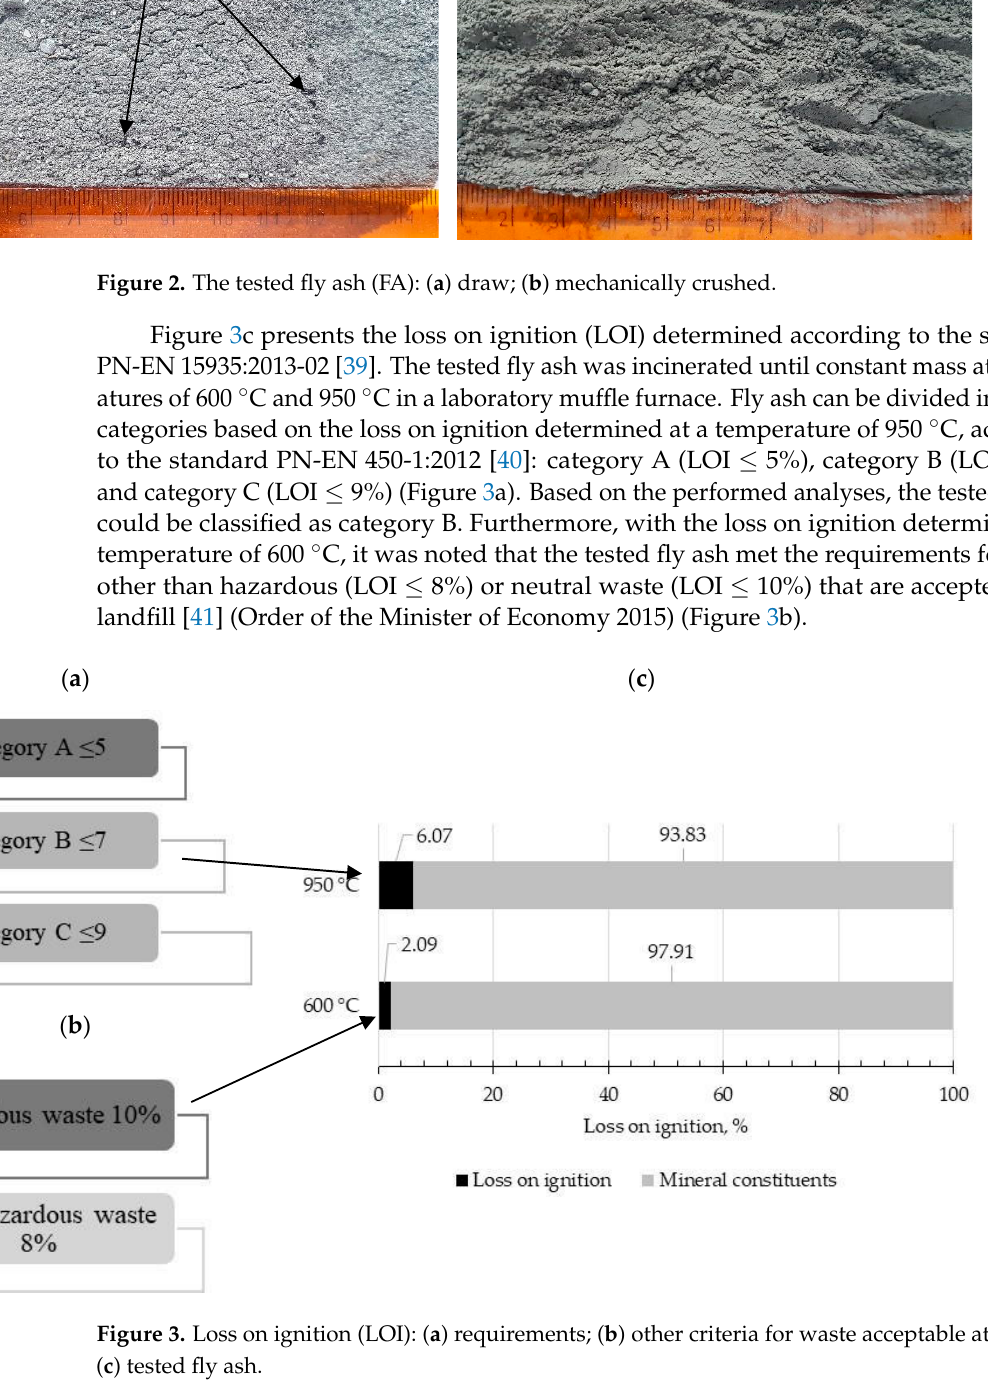
Figure 3. Loss on ignition (LOI): ( a ) requirements; ( b ) other criteria for waste acceptable at landfills; ( c ) tested fly ash.